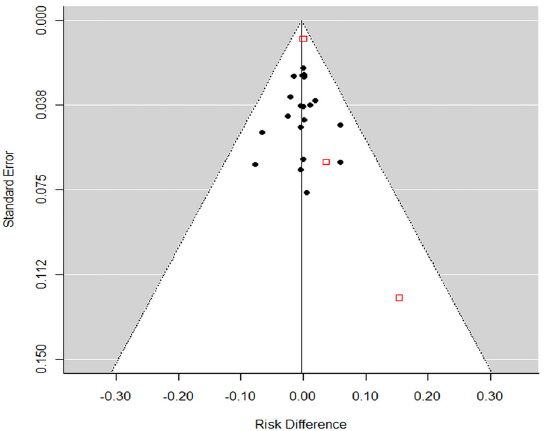
Fig 5. Funnel plot of RCTs. The red open boxes represent 1 abstract and 2 trial registry reports that have not been